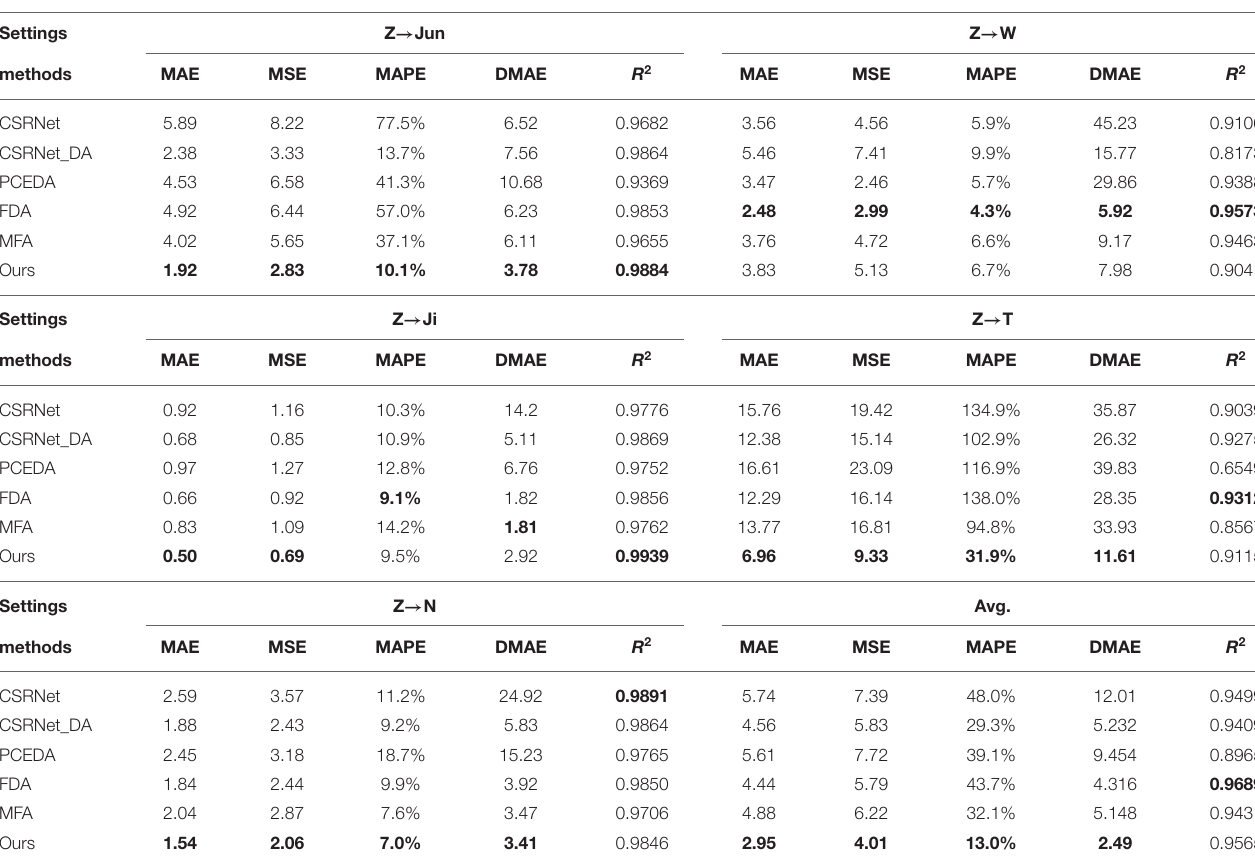
TABLE 3 | Quantitative comparisons on MTC